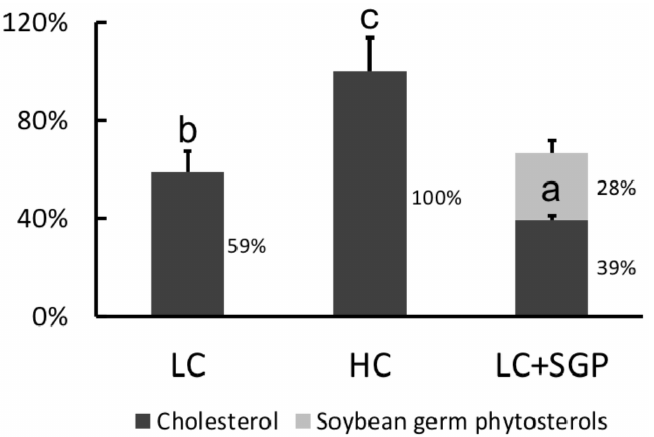
Figure 10. E ff ect of soybean germ phytosterols (SGP) on the incorporation of cholesterol into micelles. The three micellar solutions were prepared by adding cholesterol and soybean germ phytosterol into the basal micellar solution: LC, 0.25 mM cholesterol; HC, 0.5 mM cholesterol; LC + SGP, a binary mixture of 0.25 mM cholesterol and 0.25 mM soybean germ phytosterols (SGP). Data were expressed as mean ± SD, n = 6, with the amount of cholesterol in CH micelles being arbitrarily regarded as 100%. a,b,c = means with di ff erent superscript letters di ff er significantly at p <